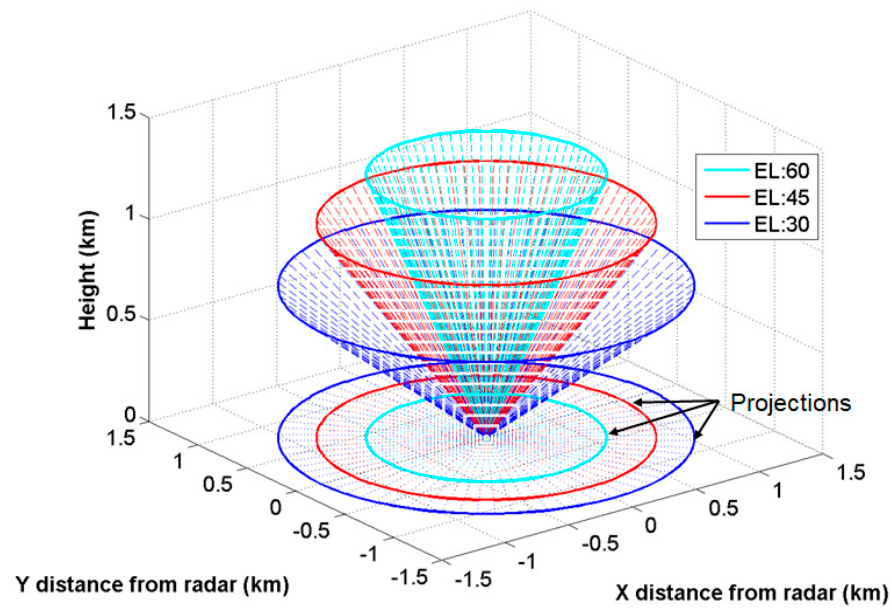
Figure 3. EWRG scan strategy. Blue, red, and cyan contours represent 30°, 45°, and 60° scans, respectively.